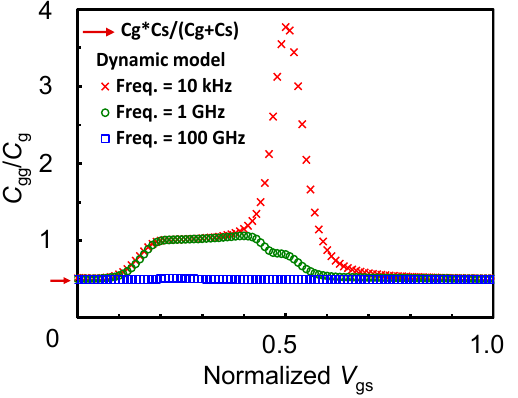
Figure 9. SET input capacitance C gg as a function of the gate voltage V gs for a drain current I d = 26.7 pA at T = 15.5 K [0.05].